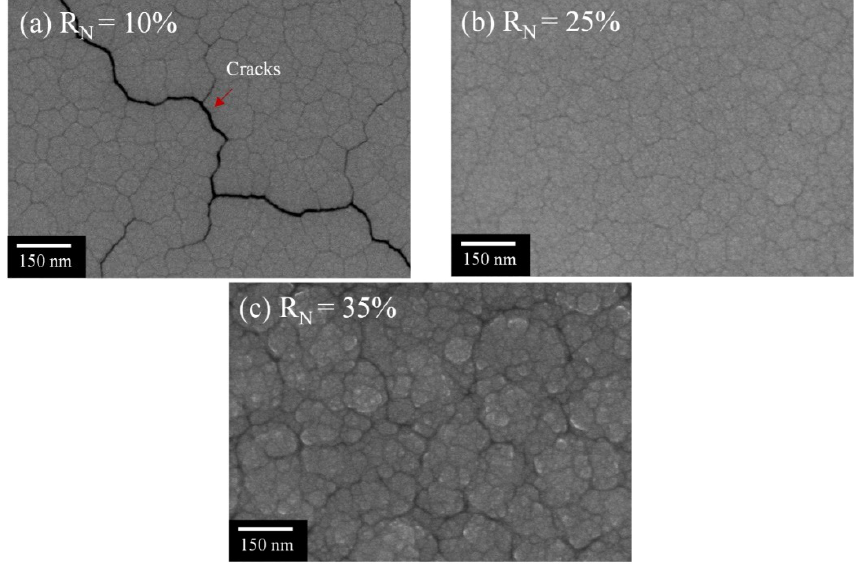
Figure 2. Surface field-emission scanning electron microscopy (FE-SEM) micrographs of the Mo–Si–N coatings deposited at N 2 gas flow ratios of ( a ) 10%, ( b ) 25%, and ( c ) 35%.